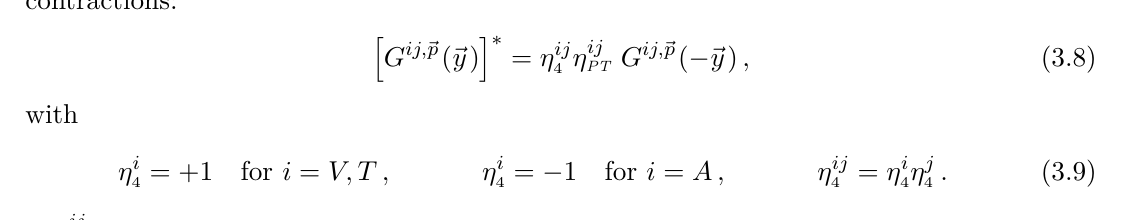
Figure 3 . Illustration of the five kinds of Wick contractions (graphs) contributing to a four-point function of a baryon. The explicit contributions for the graphs C flavor of the current insertions (red points). In the case where all quark flavors have the same mass, C 2 only depends on the flavors of the two propagators connected to the source or the sink. These flavors have to be the same for proton-proton matrix elements. For the graphs S also indicate the parts connected to the proton source and sink, i.e. G as the disconnected loops L